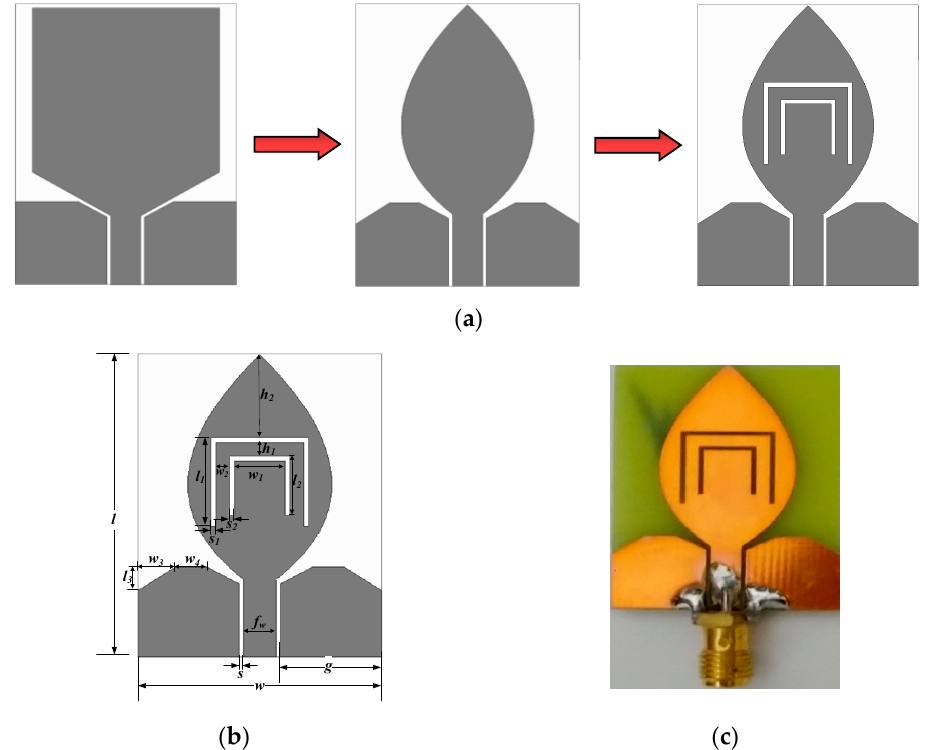
Figure 1. Geometric configuration of the antenna: ( a ) design evolution of the antenna, ( b ) antenna geometry, ( c ) fabricated antenna prototype. Table 1. Optimized dimensions of the proposed antenna.